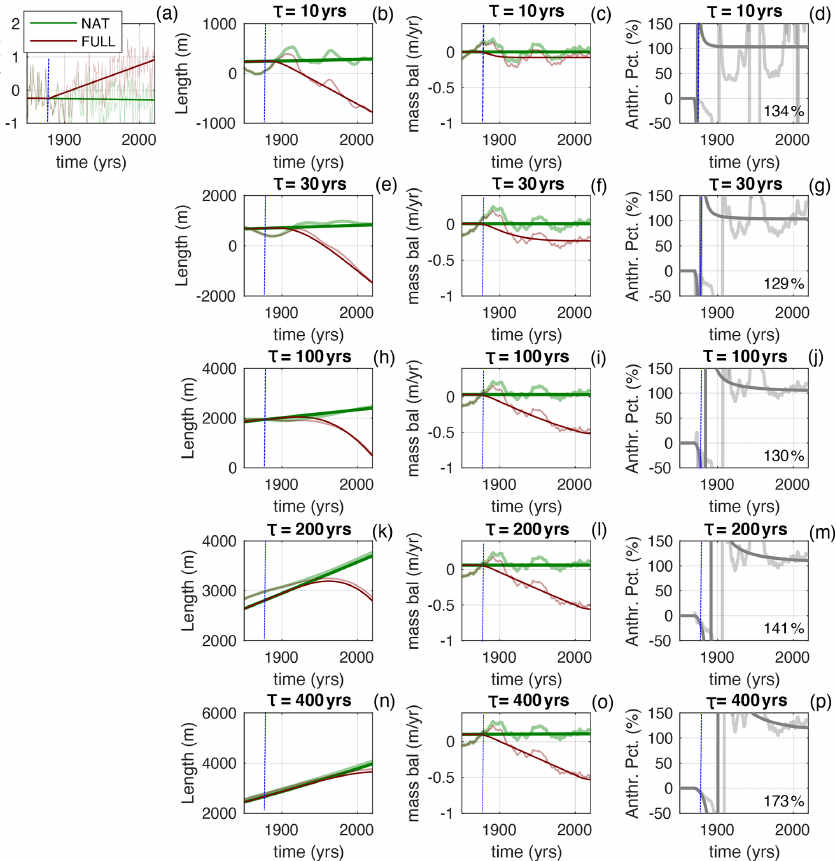
Figure 3. Same as Fig. 2 but for the period 1850 to 2020. The percentages inserted into the right-hand columns give the anthropogenic cumulative mass loss relative to the total cumulative mass loss between 1880 and 2020. Note these cumulative percentages will not, in general, be equal to the time average of F anth